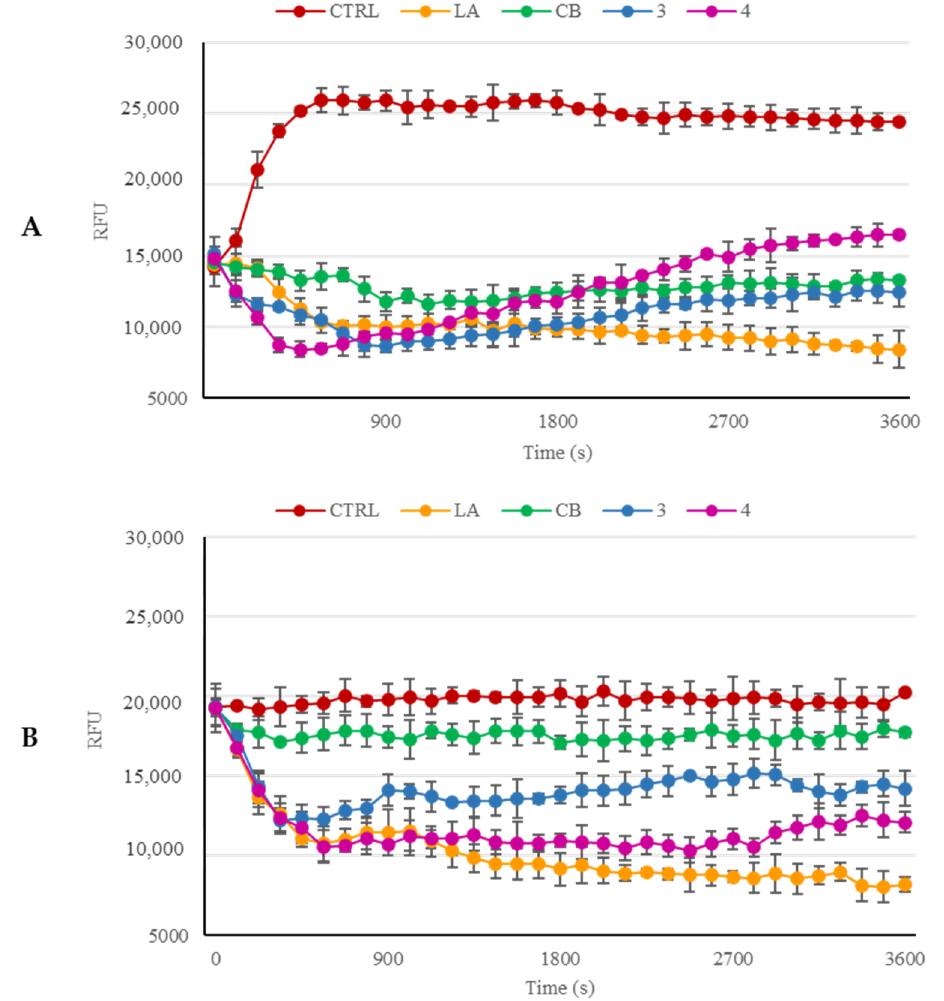
Figure 5. ( A ) In vitro actin polymerization assay. Compounds 3 and 4 (used at the concentration of 5 µ M) were incubated with the labeled rabbit muscle actin in order to verify their ability to inhibit the protein polymerization. ( B ) In vitro actin depolymerization assay. After actin polymerization, compounds 3 and 4 (5 µ M) were added to the reaction mixture, in order to determine their ability to act as depolymerizing agents. For both the assays, the vehicle DMSO was used as a negative control. Actin-targeting agents, LA and CB, both at the concentration of 5 µ M, were used as positive controls. The assemblage of the actin filaments was established by monitoring the fluorescence ( λ Ex/Em = 365/410 nm) in kinetic mode for 1 h at room temperature by using a microplate reader. The graphics are representative of three separate experiments and error bars represent the standard